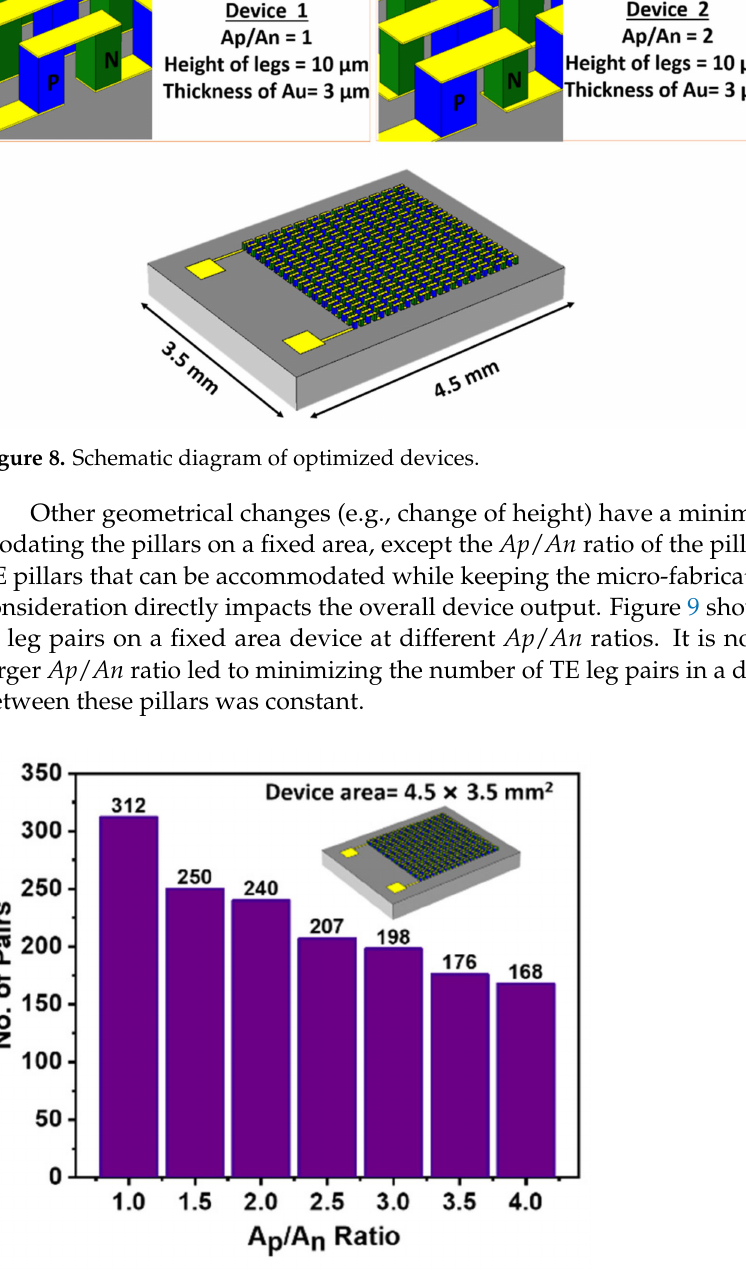
Figure 9. Numbers of leg pairs for each Ap / An ratio